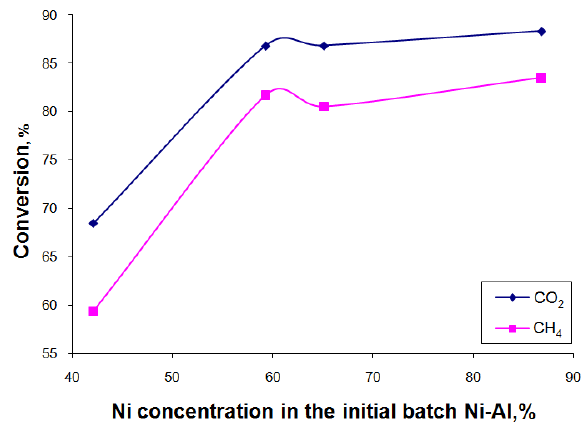
Figure 9. Influence of amount of nickel in the initial mixture on the catalytic activity.